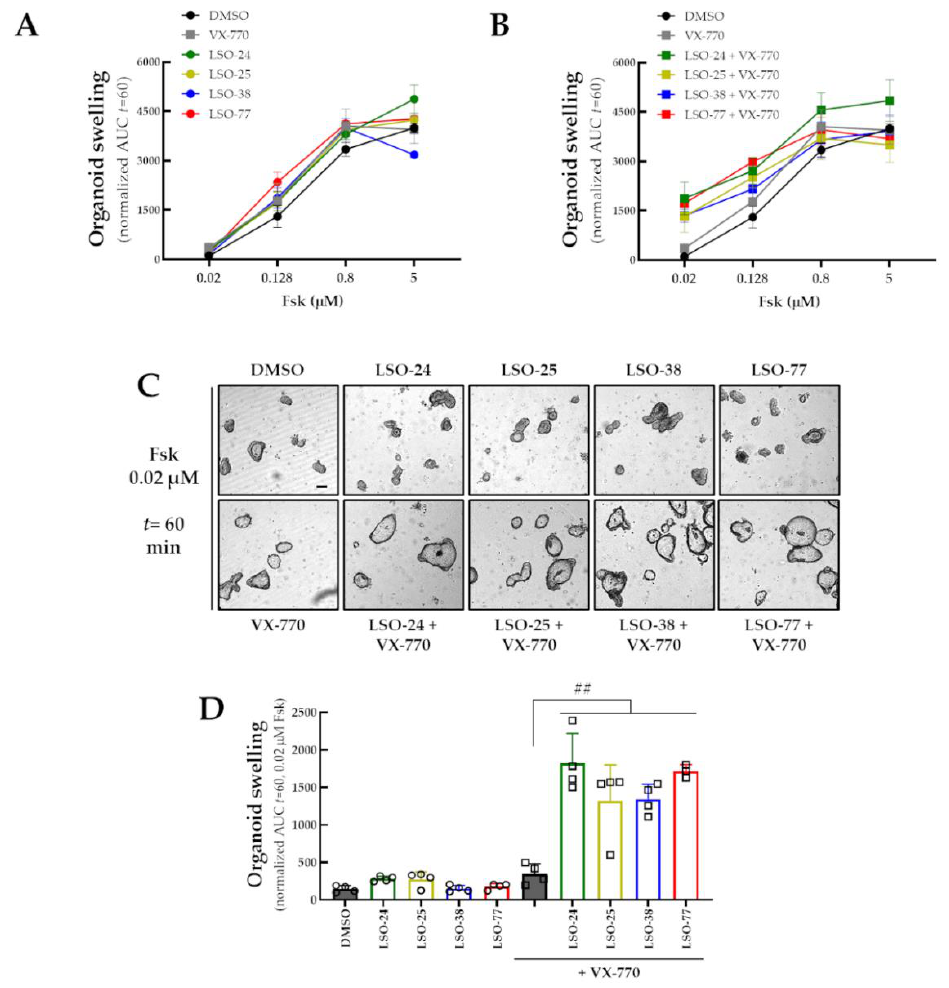
Figure 6. Assessment of additivity of potentiators activity on R334W-CFTR function in intestinal organoids. ( A , B ) Quantification of FIS in intestinal organoids from an individual with CF (R334W/R334W genotype) for all test compounds ( A ) individually and ( B ) in combination with VX-770 at Fsk concentrations of 0.02, 0.128, 0.8, and 5 µM, expressed as the AUC of organoid surface area increase (baseline = 100%, t = 60 min). ( C ) Representative images of intestinal organoids (Scale bar: 50 µm) and ( D ) quantification at 0.02 µM Fsk for test compounds individually or in combination. Data are represented as means + SD: ## P < 0.01 vs. VX-770 alone.